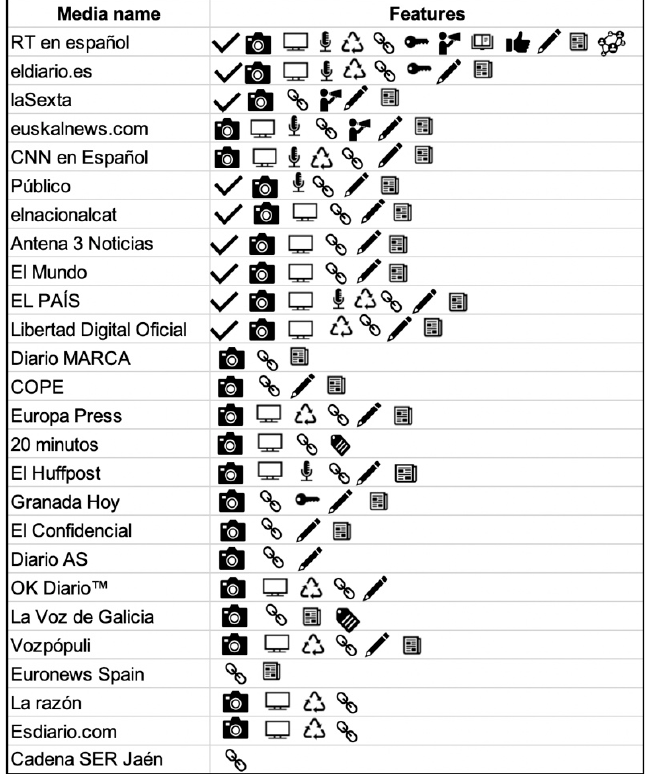
Figure 3. List of other features. Source: own elaboration.